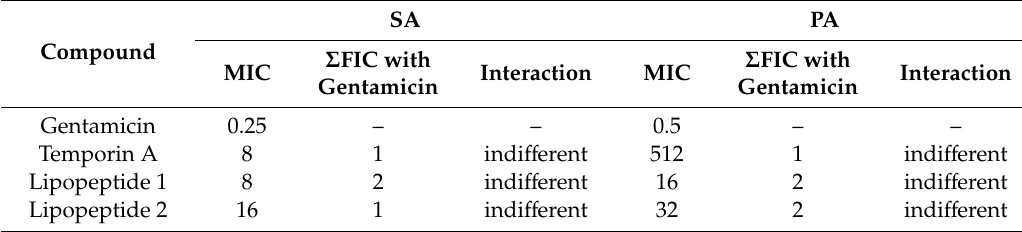
Table 1. Activity against planktonic bacteria: minimum inhibitory concentration (MIC) (mg / L) and fractional inhibitory concentration index ( Σ FIC) determined for gentamicin and antimicrobial peptides against Staphylococcus aureus (SA) and Pseudomonas aeruginosa (PA). SA PA Compound Σ FIC with Σ FIC with Interaction Interaction MIC MIC Gentamicin Gentamicin Gentamicin 0.25 – – 0.5 – – Temporin A 8 1 indi ff erent 512 indi ff erent Lipopeptide 1 Lipopeptide 2 indi ff erent indi ff erent